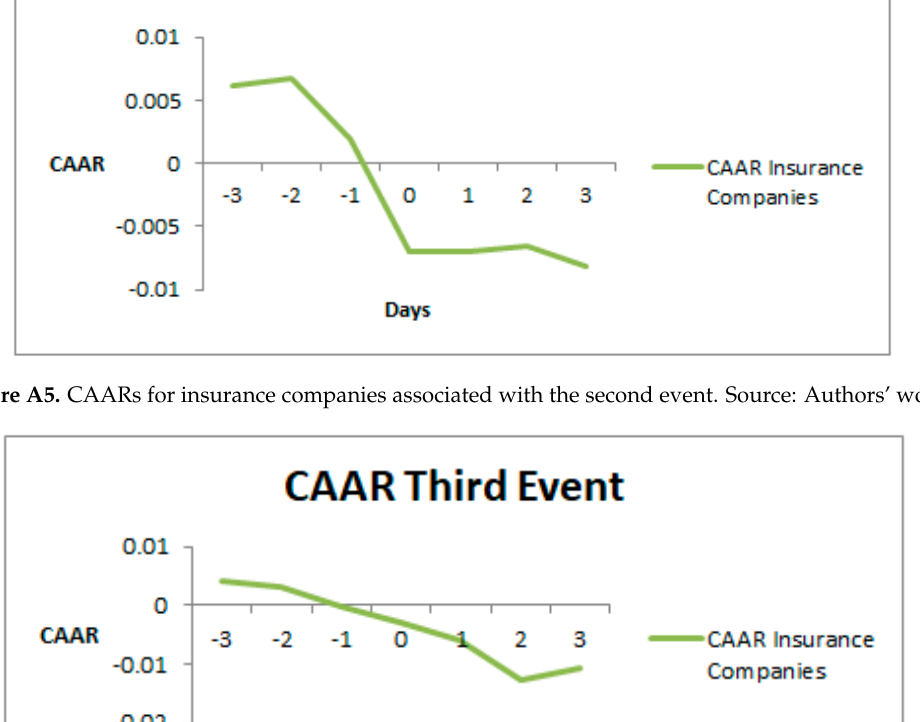
Figure A6. CAARs for insurance companies associated with the third event. Source: Authors’ work.